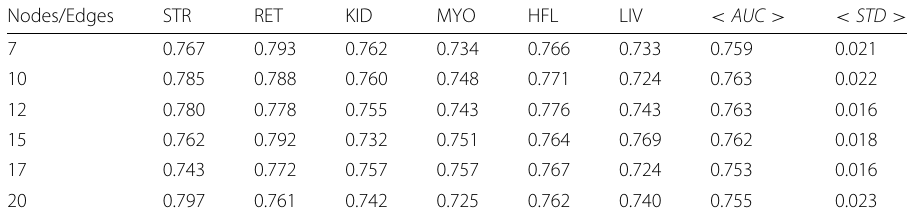
Table 6 Average area under the curve ( < AUC > ) values and Standard Deviations ( < STD > ) for each complication of diabetes based upon the number of significant nodes and edges that were included in the prediction Nodes/Edges